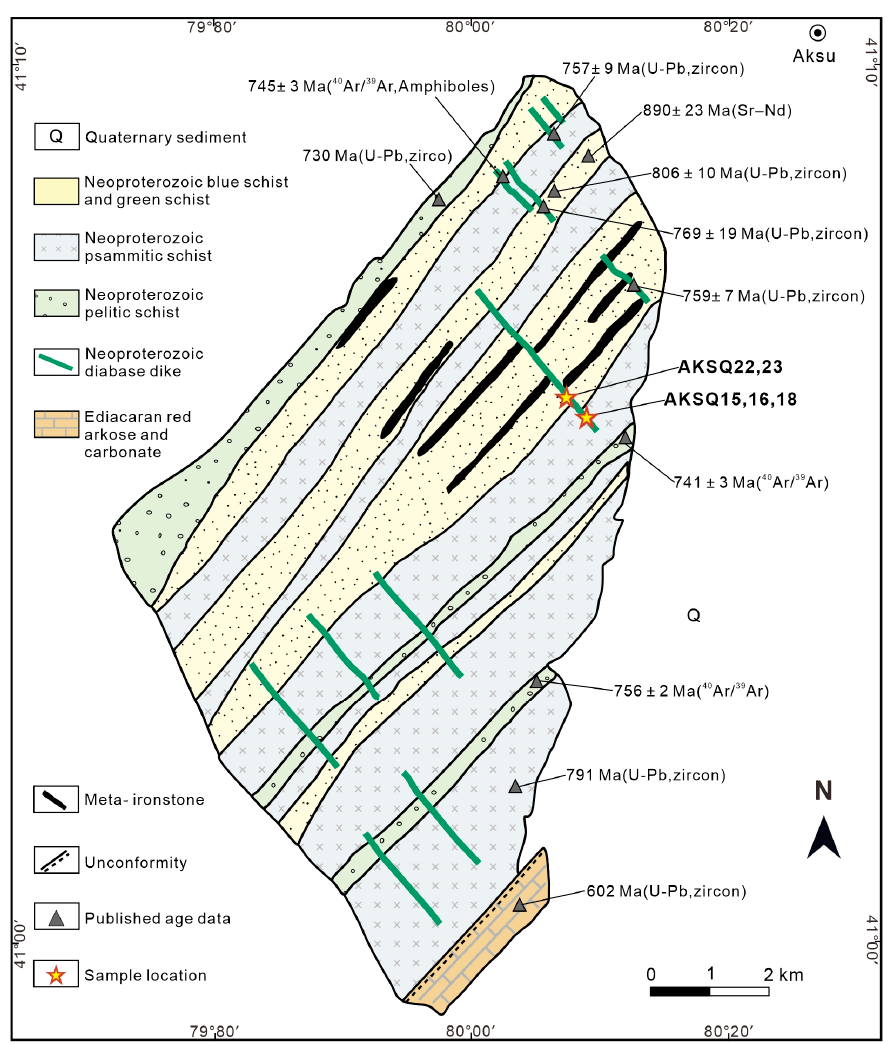
Figure 2. Simplified geological maps of the Aksu terrane with locations of samples (modified from [39,40]), as well as published ages for the diabase dykes and Precambrian schist [39–44]. The Aksu district is localized in the southwestern part of Chinese South Tianshan (Figure 1c). The Precambrian basement belts are composed mainly of the Neoproterozoic Aksu Group and Ediacaran Sugetbrak Formation [41]. The Aksu Group is mainly exposed in southwestern Aksu (Figure 2), including greenschist, blueschist, psammitic schist, pelitic schist, and metagreywacke [39,42]. The blueschist protolith has been dated to be of ca. 806–754 Ma based on whole-rock 40 Ar/ 39 Ar and detrital zircon U–Pb dating methods [39,40]. The pelitic schist has a 40 Ar/ 39 Ar age of 756–741 Ma [43] or detrital zircon U–Pb age of 730 Ma [42]. The psammitic schist has a detrital zircon U–Pb age of ca. 791 Ma [43]. The deformed sequence of the Aksu Group is crosscut by a series of NW-striking diabase dykes (Figures 2 and 3a), which have U–Pb zircon ages of 759 ± 7 Ma (SHRIMP; [27]) and 757 ± 9 Ma (LA–ICP–MS; [44]). In addition, amphibole from the